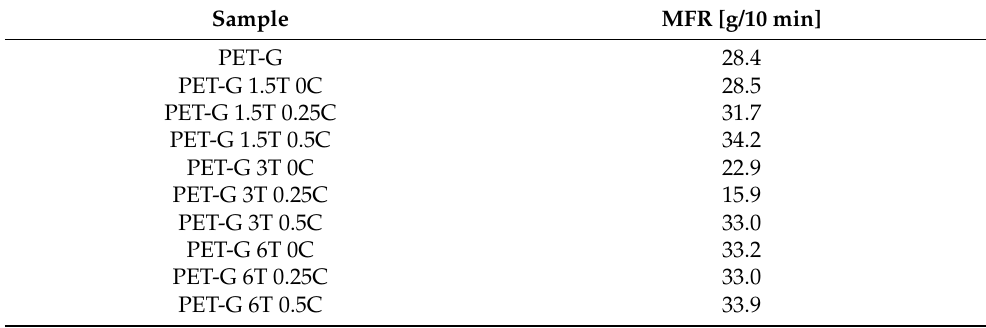
Table 3. MFR test results of PET-G and prepared composites.